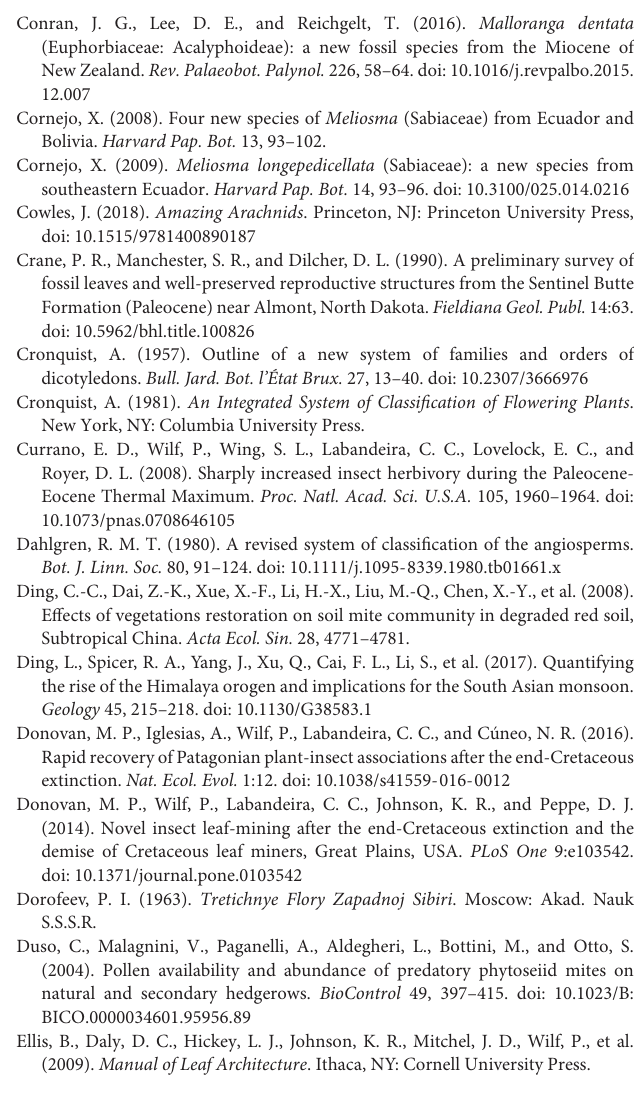
Supplementary Table 1 | Fossil record of Meliosma